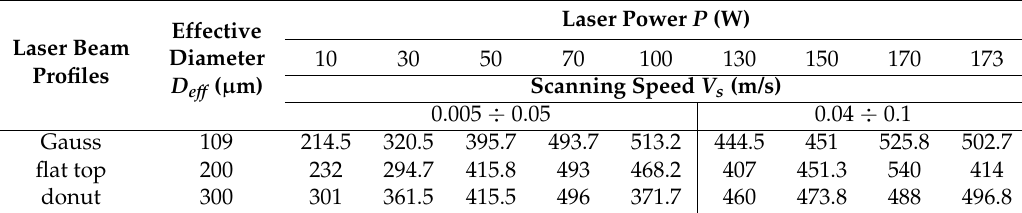
Table 5. The average values of heat-affected zone (HAZ) C z.a (µm) during SLM production of single tracks from CoCrMo powder with the height of the layer ~80 µm.